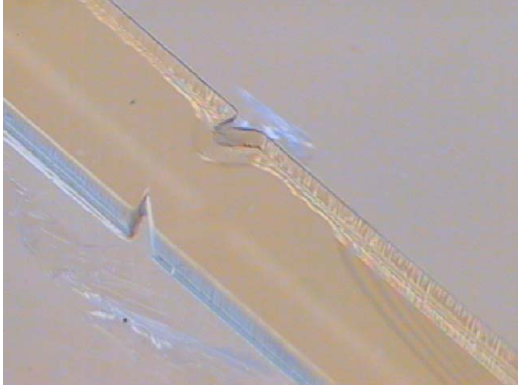
Figure 8. Drawing of the SU-8 structure with a height of 500 μ